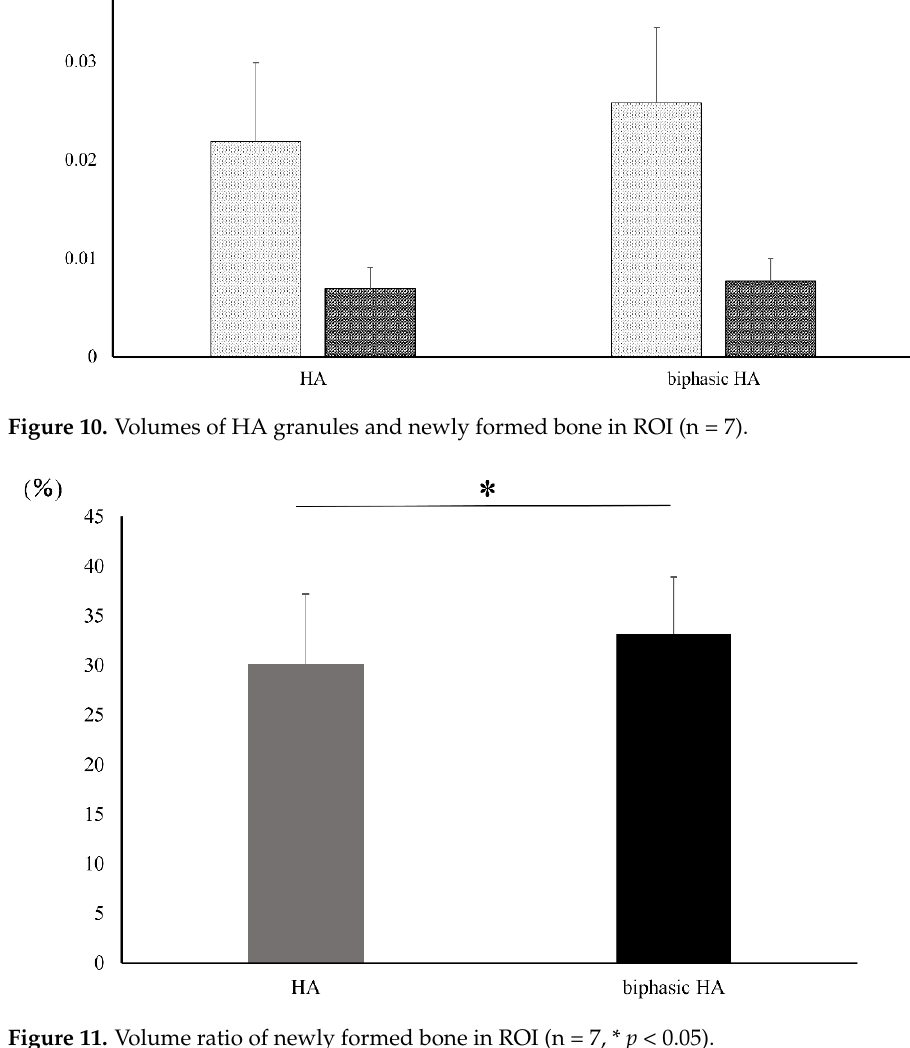
Figure 12. BMD image: ( a ) biphasic HA granules, ( b ) HA granules, ( c ) bone defect.